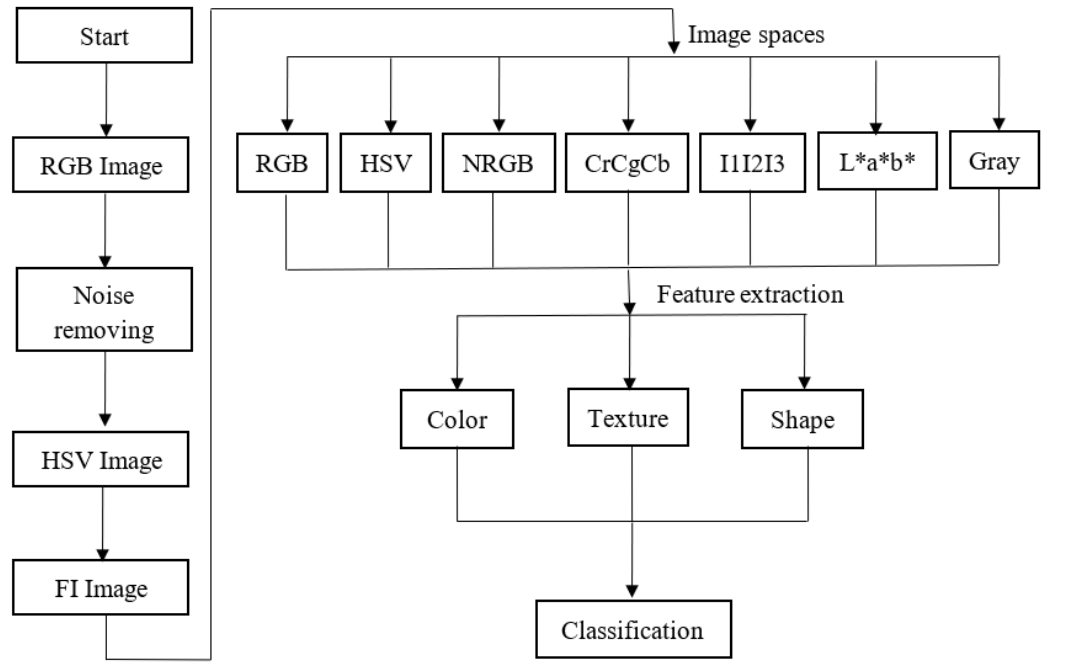
Figure 2. The developed image processing algorithm.